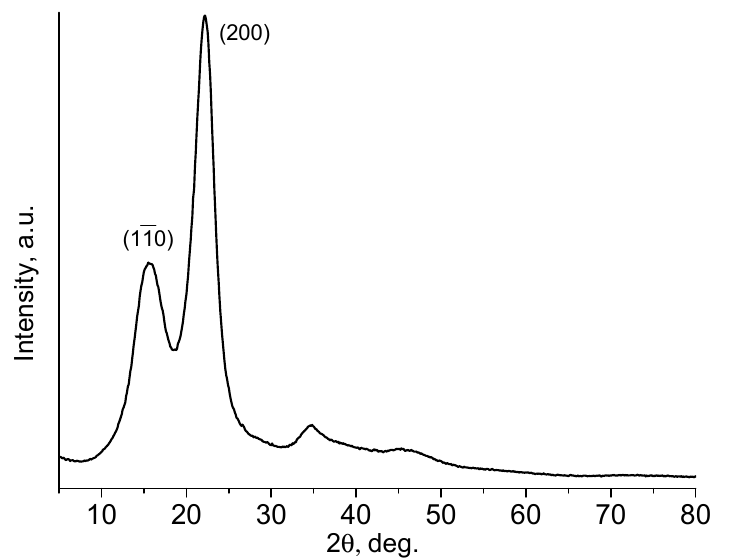
Figure 3. XRD patterns of HogC cellulose at ambient temperature.